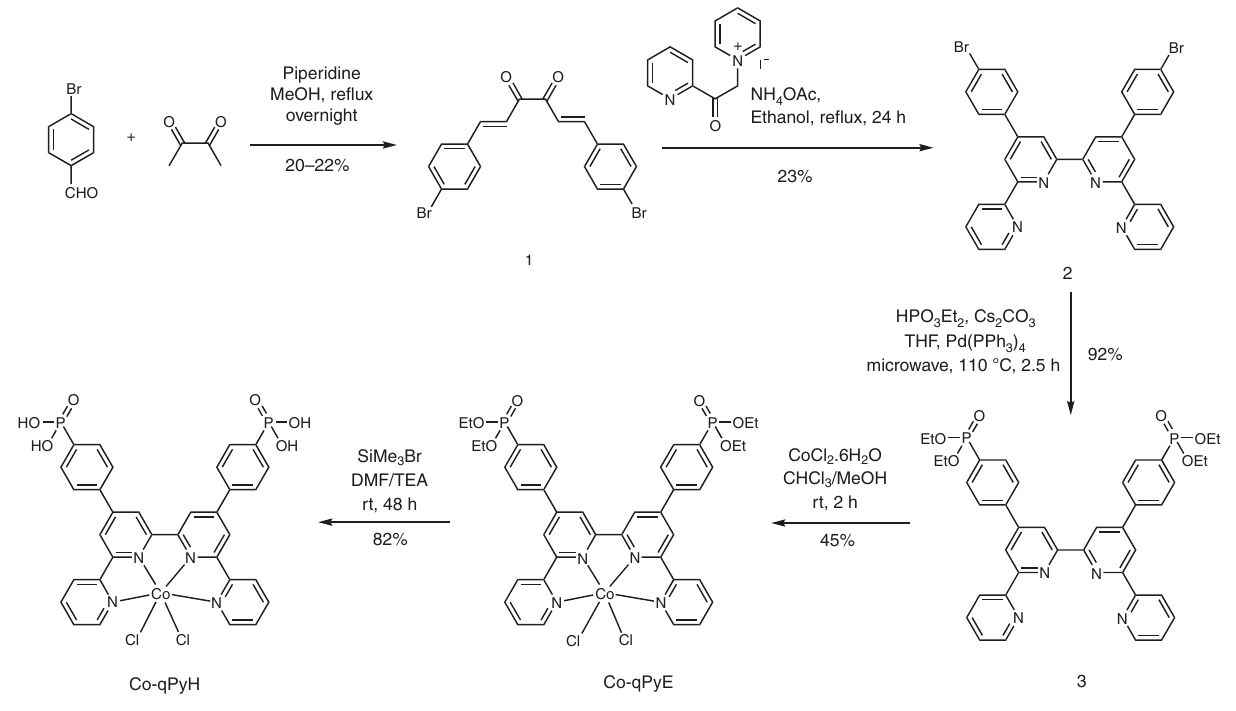
Fig. 7 Synthetic route for Co-qPyH. Successive synthetic steps along with chemical